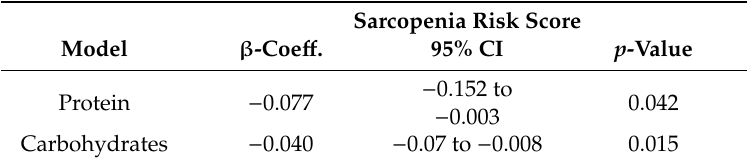
Table 3. E ff ect of isocaloric substitution of fat with either protein or carbohydrates on sarcopenia risk score in older European adults.